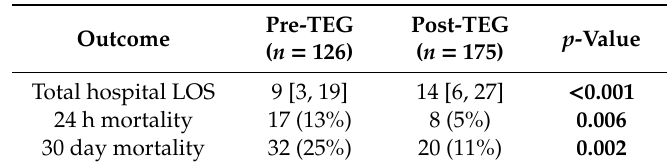
Table 2. Mortality.